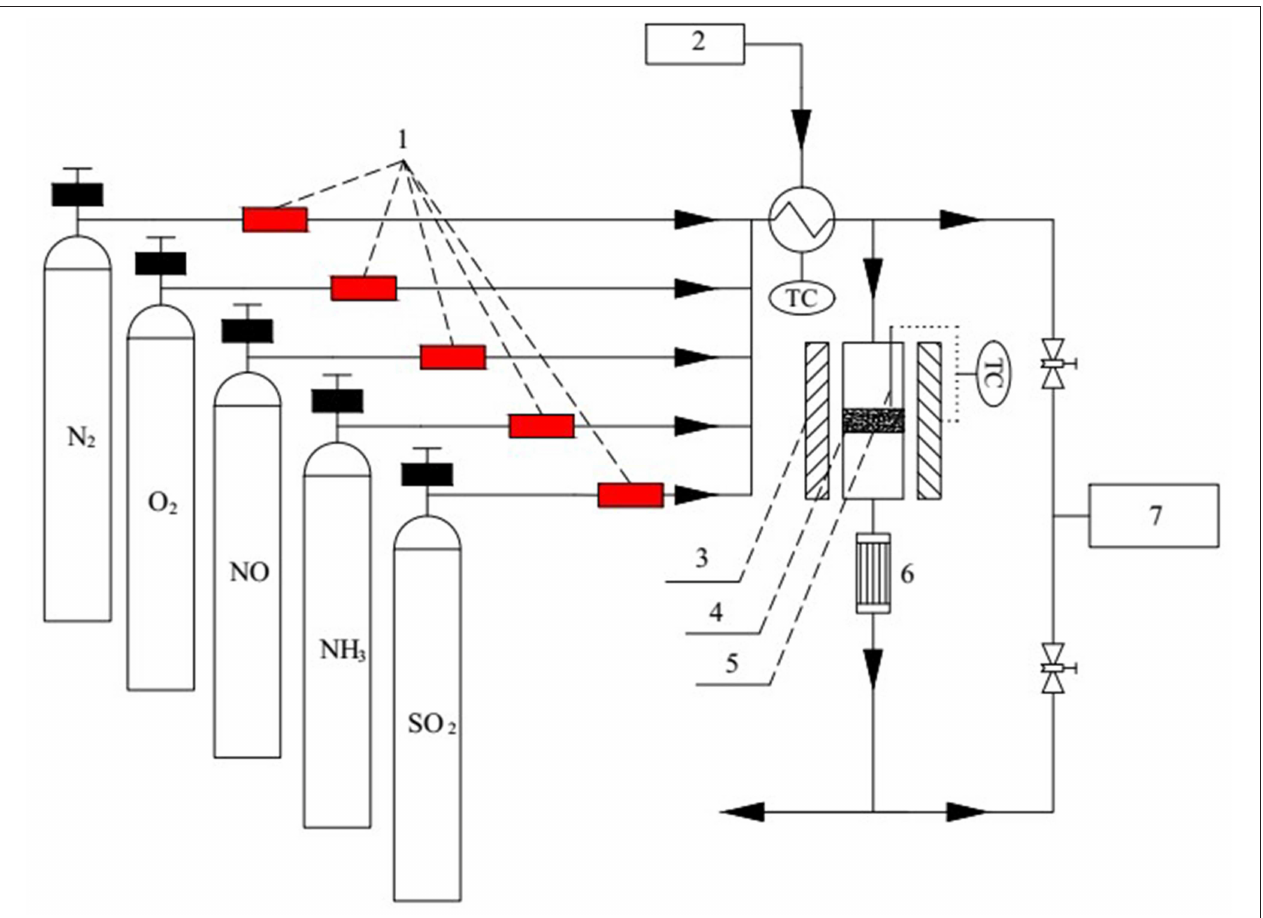
FIGURE 1 | Diagram of the fixed-bed reactor (1-mass flowmeter, 2-preheater, 3-reactor, 4-catalyst, 5-thermocouple, 6-condensator, 7-flue gas